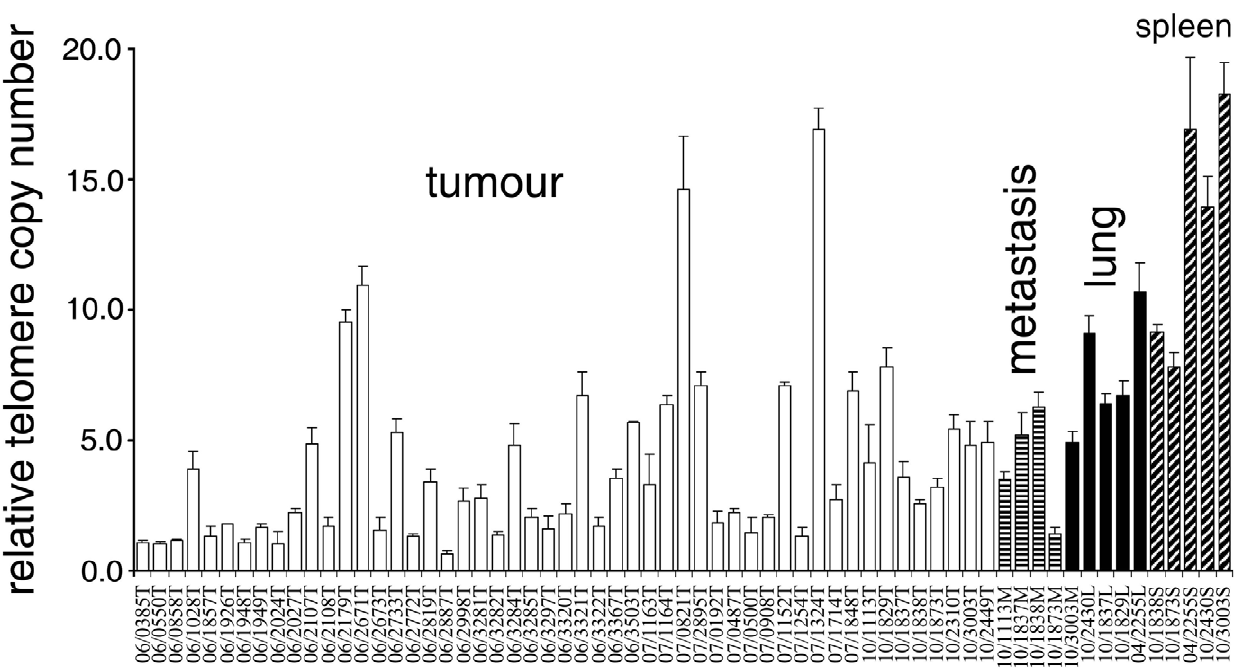
Figure 3. Relative telomere copy number is lower in DFT samples than in other devil tissues. Error bars depict standard deviations. Sample names indicate the time of collection (06=2006, 07=2007, 10=2010). Identical numbers represent different tissue samples collected from the same animal. Number of samples used in the analysis: primary tumours collected in 2006: N=30, 2007: N=13 and 2010: N=8; metastasis: N=4, spleen: N=5, lung: N=5.